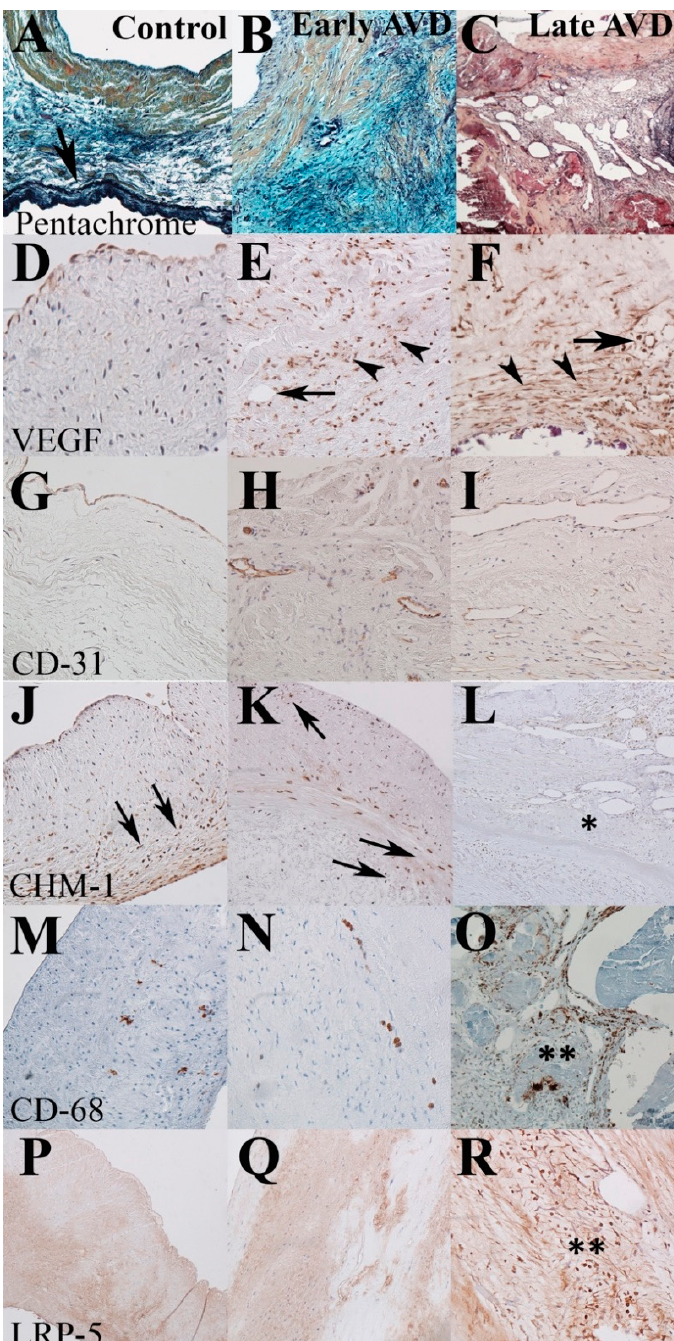
Figure 1. Aberrant angiogenesis in early-onset AVD precedes inflammation and atherosclerosis. Representative sections from control (left), early-onset AVD (center), and late-onset AVD (right) specimens. Normal elastic fiber structure is localized to the ventricularis layer of the cusp (arrow, A ). Both early- and late-onset AVD are characterized by EFF and dispersion ( B , C ). Provisional (arrowhead) and overt (arrow) angiogenesis ( D ) is seen in early- ( E ) and late-onset ( F ) AVD, characterized in part by endothelial markers around neovessels ( H , I ) not observed in controls ( G ). Angiostatic CHM ( J , K ) is decreased in areas of angiogenesis in late-onset AVD (asterisk, L ). Nominal CD-68 is seen in early-onset AVD ( N ), similar to control ( M ), corresponding with no atherosclerosis as demonstrated by absent LRP-5 staining ( P , Q ), both of which were markedly increased in late-onset AVD (double asterisks, O , R ). The ventricularis cusp layer is oriented at the bottom of all panels. Chondromodulin, an angiostatic factor, is decreased in all AVD specimens, as previ- ously described [10]. Importantly, the inflammation marker CD-68 is strongly expressed